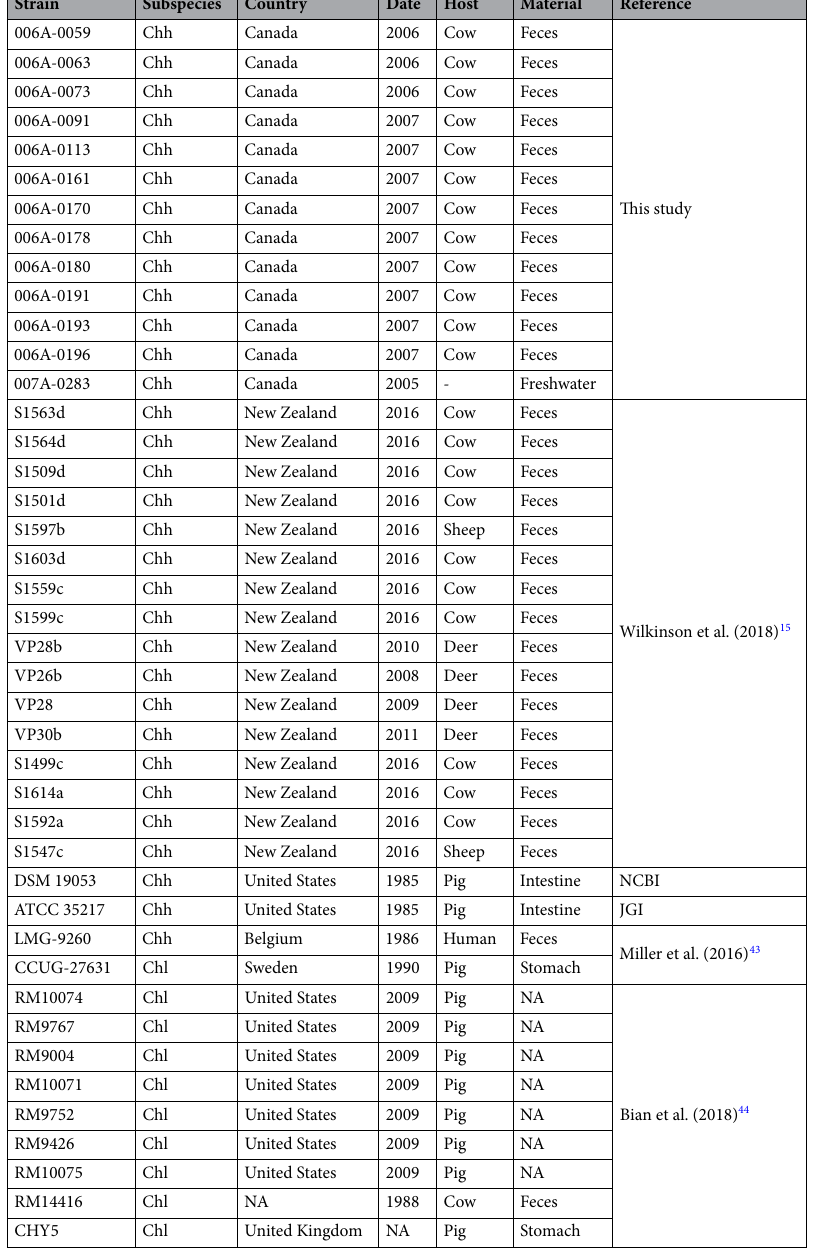
Table 1. Information of C. hyointestinalis genomes analyzed in this